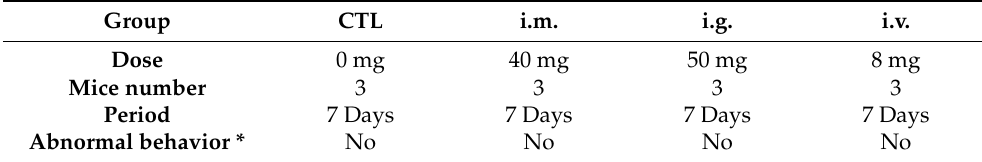
Table 1. Mice groups exposed by three different drug delivery routes. Group CTL i.m. i.g. i.v. Dose 0 mg Mice number